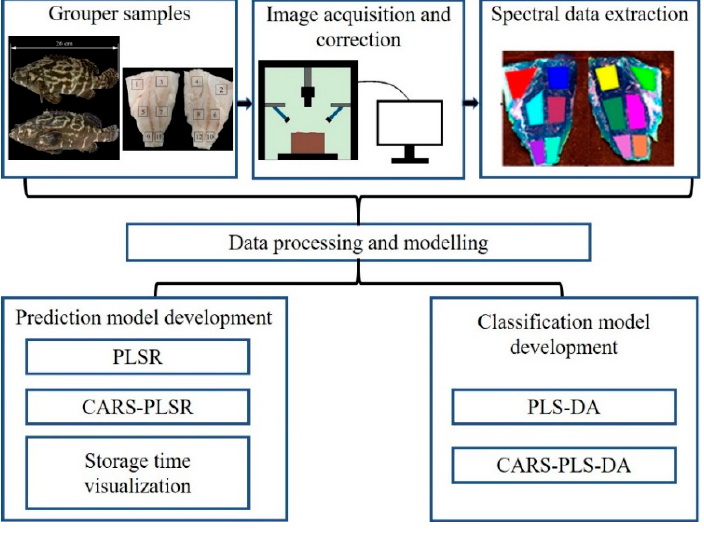
Figure 1. Workflow chart for data processing.